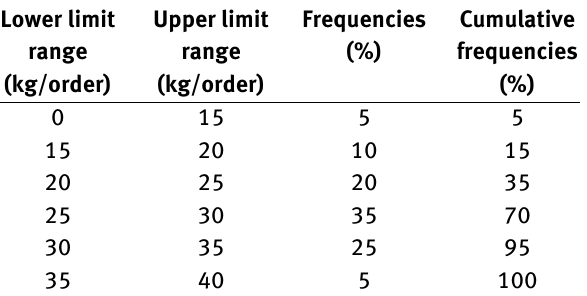
Table 1: Frequency of quantities supplied by order.* Lower limit